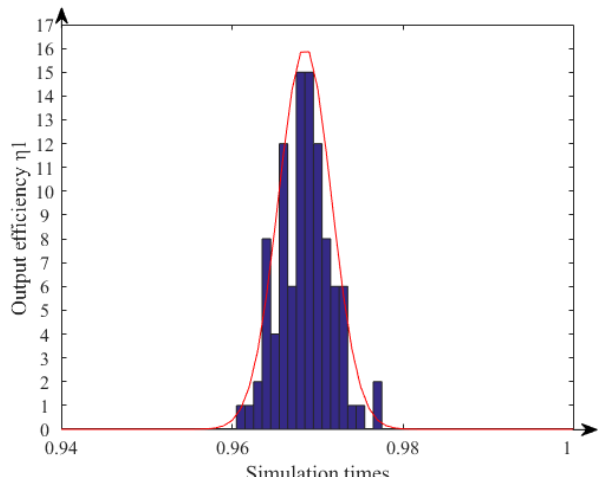
Figure 20. The distribution of the functional requirement value of outputting TCM.